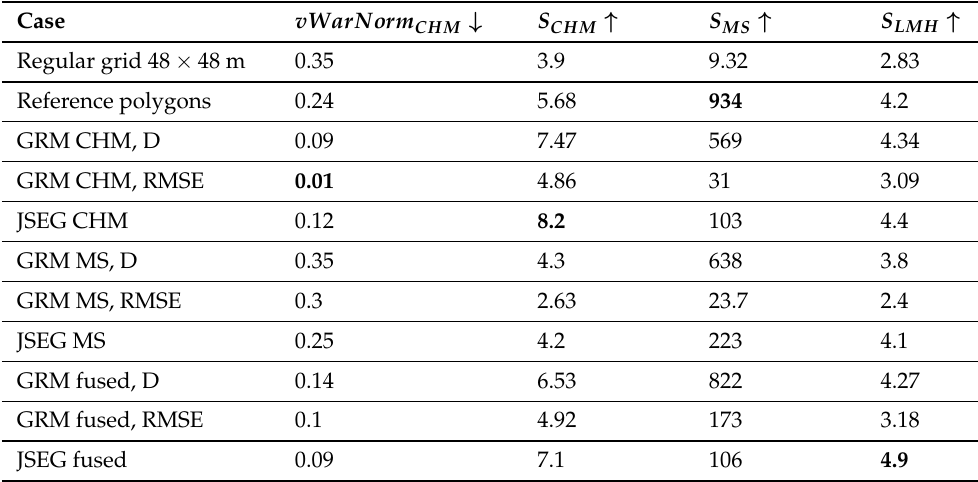
Table 3. Unsupervised metrics. Arrows as better. The best value for each metric is emphasised with bold font.